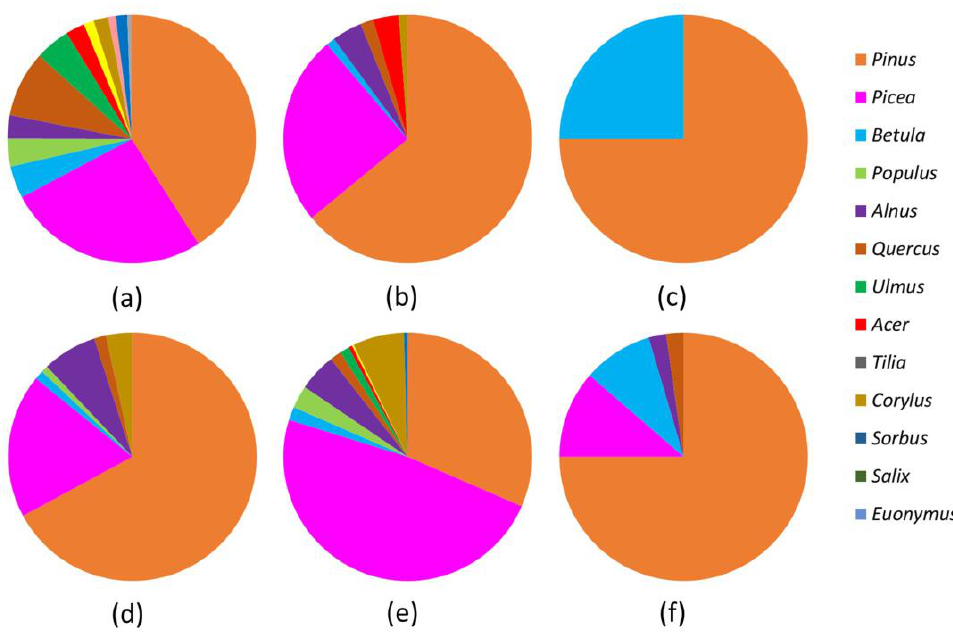
Figure 4. Taxonomic composition of soil charcoal in different local areas (sites): ( a ) Zavorovka- Likhusha, ( b ) Runa-Zaborovka, ( c ) Voroshilovo, ( d ) Krasnyi Bor.